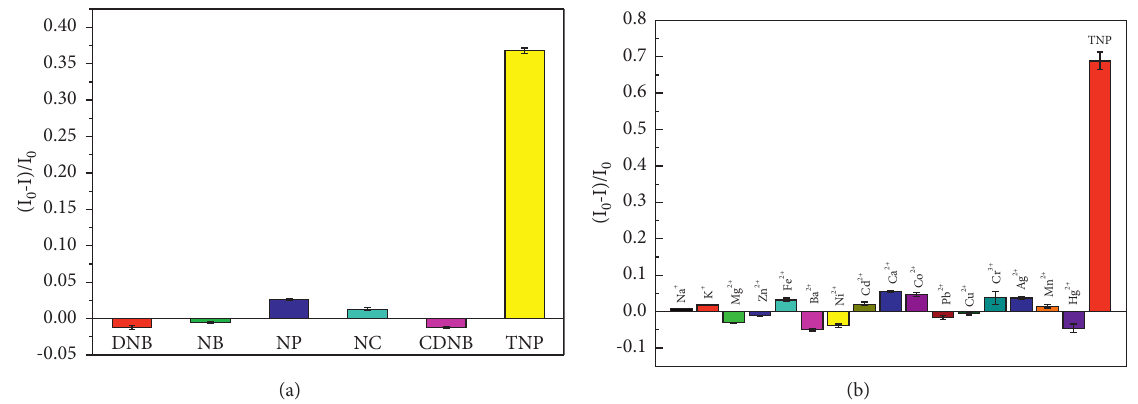
0 and I represent the fluorescence